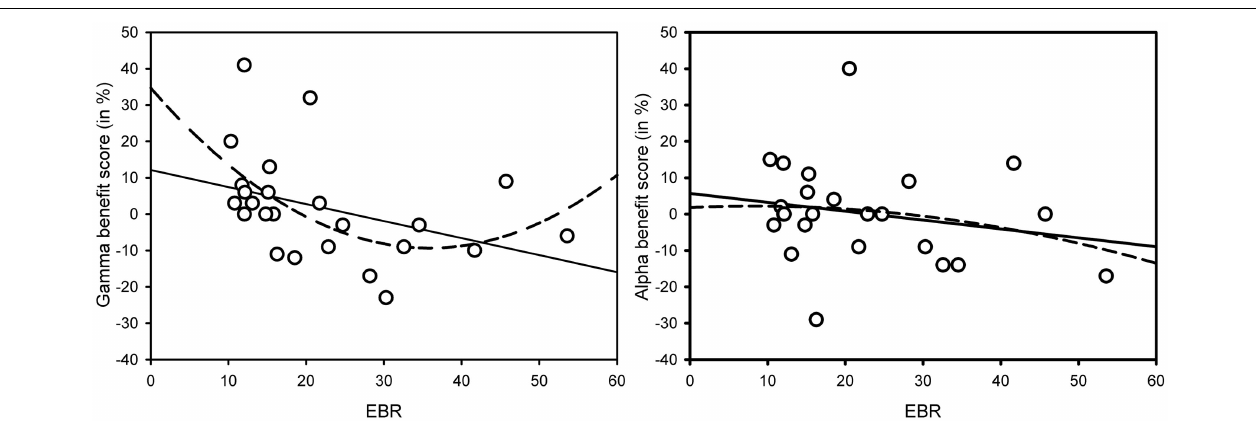
FIGURE 2 | Linear (solid line) and quadratic (dotted line) relationships between gamma-frequency AB benefit scores on lag 3 and EBR [left-hand graph – linear: F (1, 22) = 3.89, p = 0.061; quadratic: F (2, 21) = 3.84, p = 0.038] and alpha-frequency AB benefit scores on lag 3